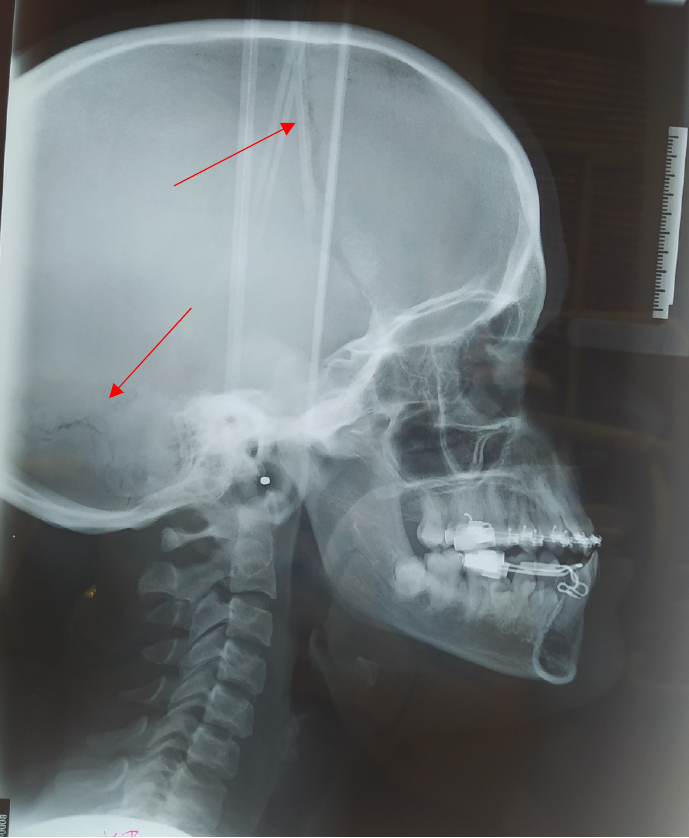
Figure 15. Teleradiography X-ray of sagittal plane in 2021, presence of open cranial sutures (red arrows).